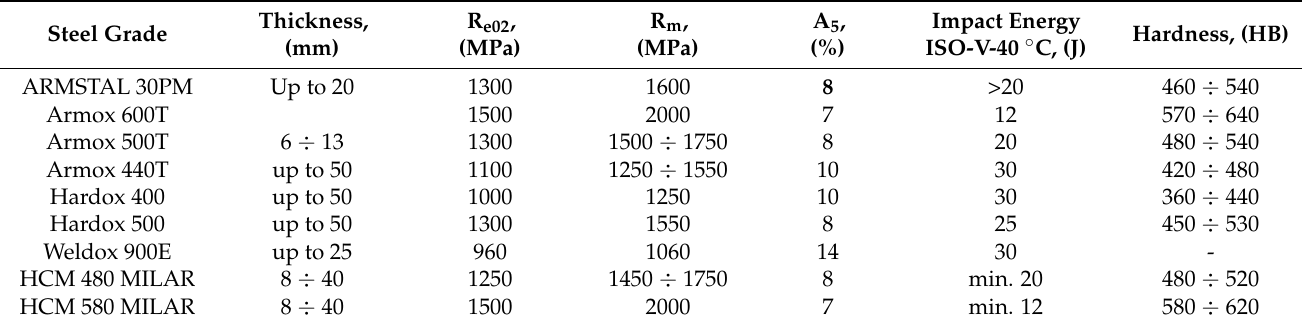
Table 2. Mechanical properties of ARMSTAL 30PM steel in relation to other steels with similar hardness (adapted from